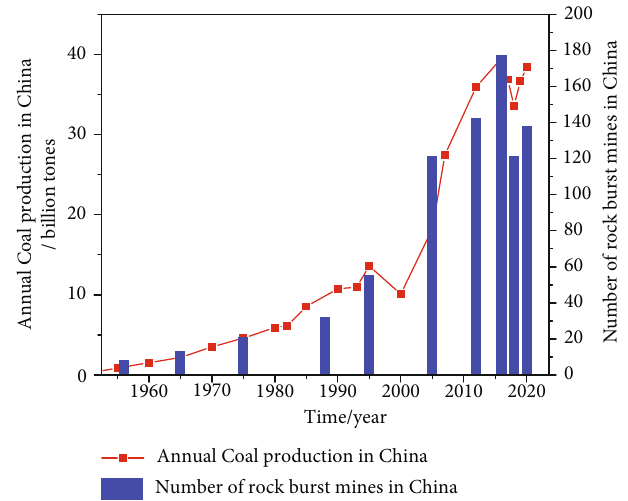
Figure 1: Annual coal production and the number of coal bump mines in China